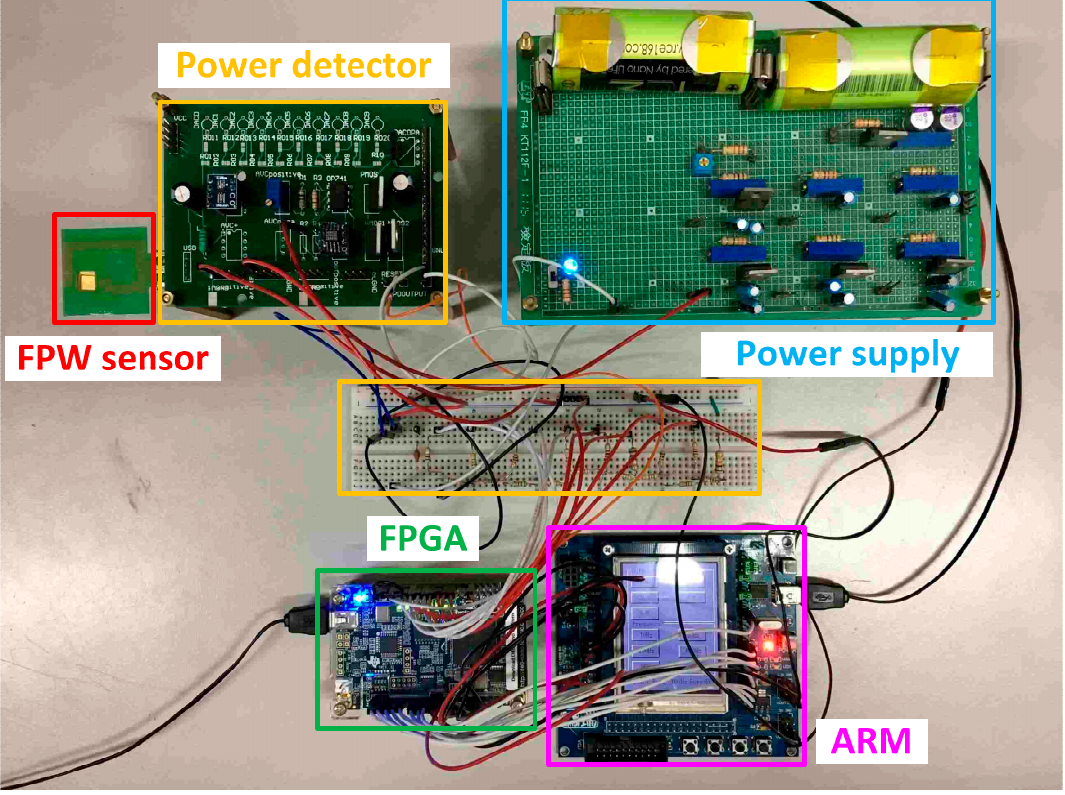
Figure 7. Photo of the system prototype measurement environment.